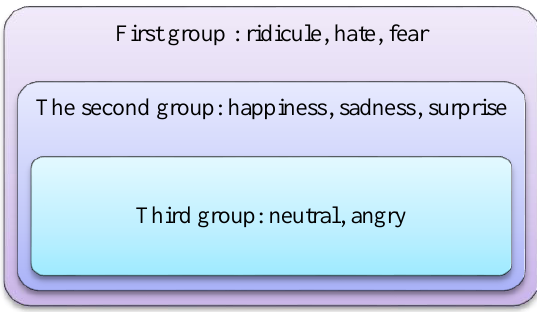
Figure 10. Results from the study of the faces mode in children with